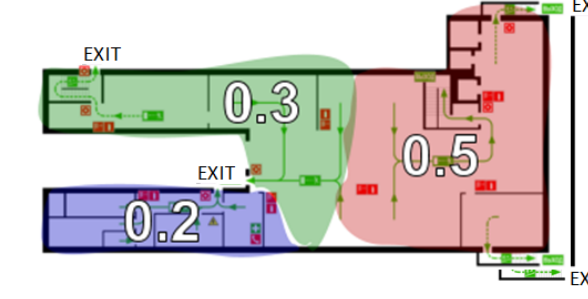
Figure 1: Evacuation plan. Figure 2: People density inside building area.